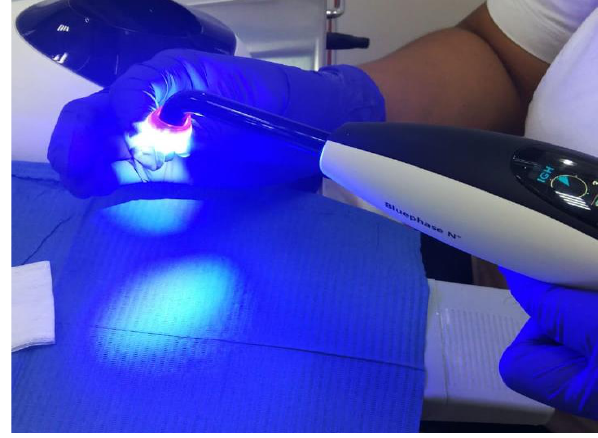
Figure 2. Sample units according to study group. ( A ) No dentin conditioning (Control), ( B ) dentin conditioned with 18% EDTA, ( C ) dentin conditioned with 35% H 3 PO 4 and ( D ) dentin conditioned with 18% EDTA plus 35% H 3 PO 4 .